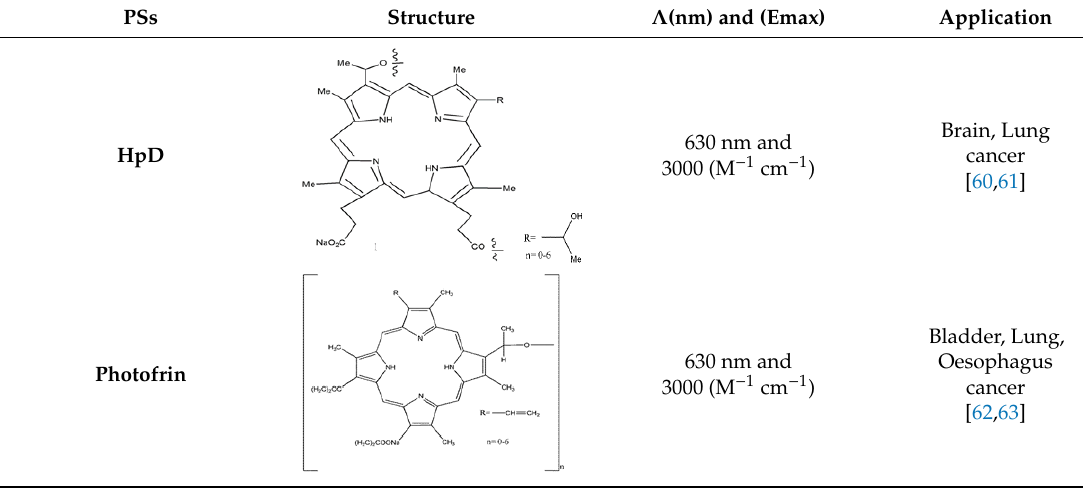
Table 2. Properties of photosensitizers and its application in cancer.